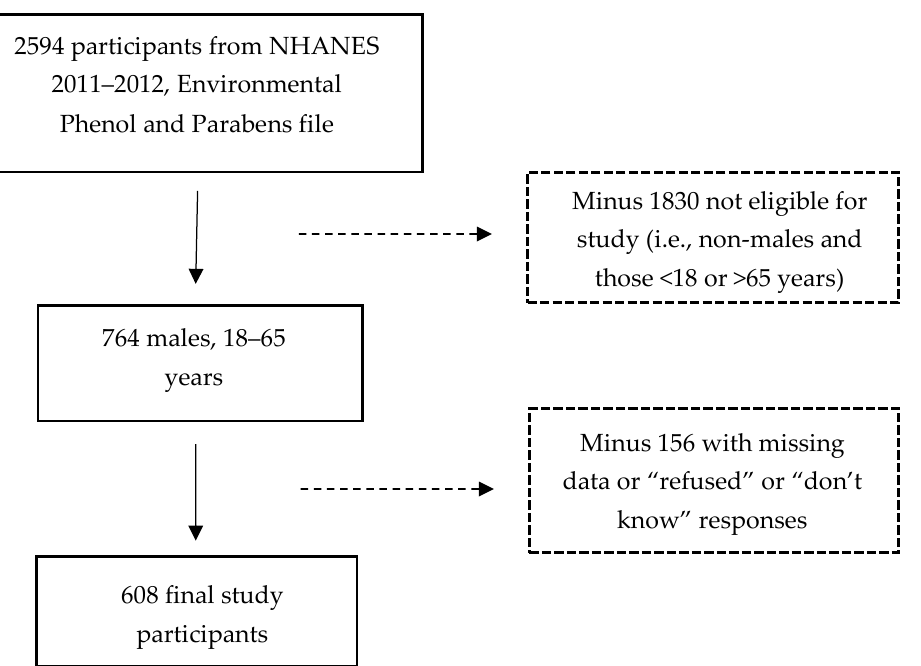
Figure 1. Selection of study sample. NHANES, National Health and Nutrition Examination 96